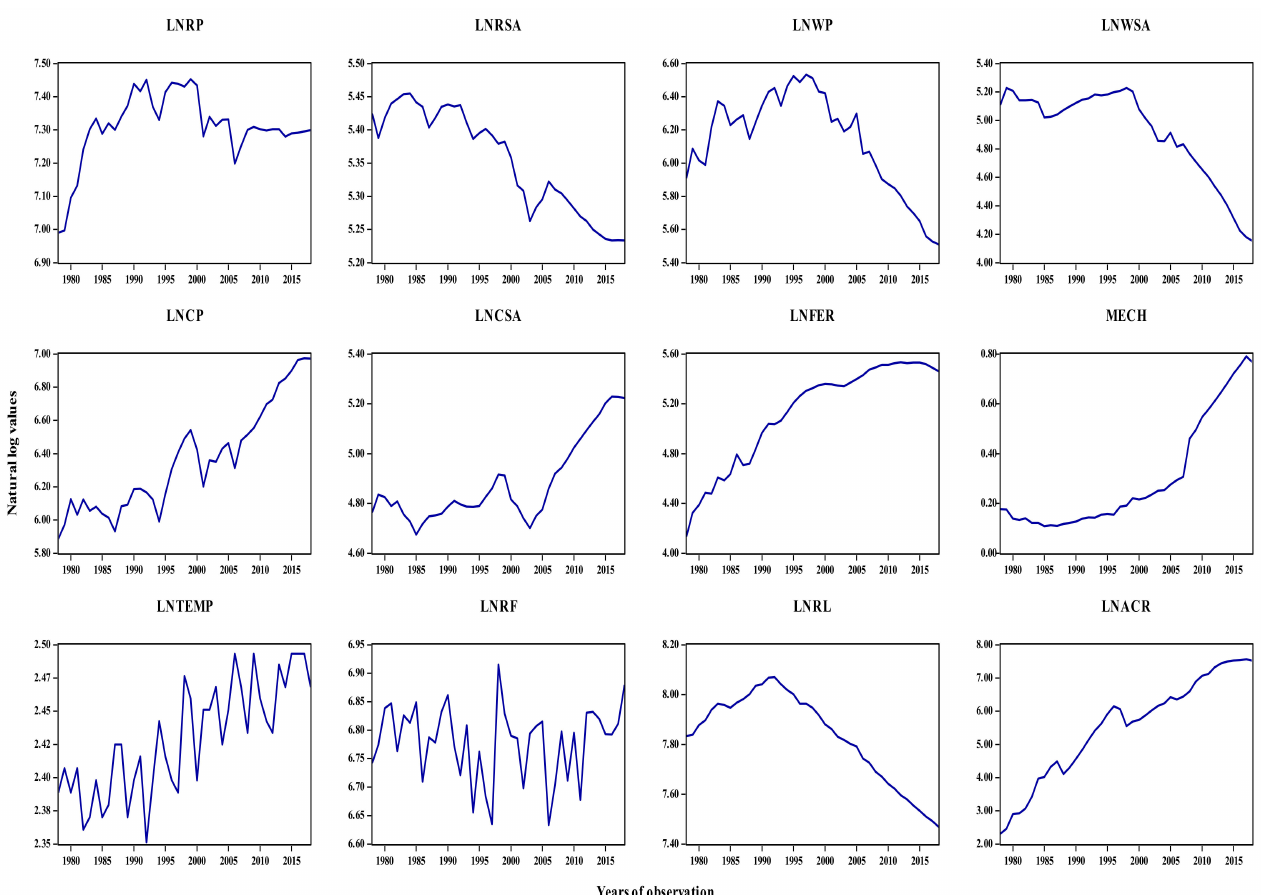
Figure 4. LNRP, LNRSA, LNWP, LNWSA, LNMP, LNMSA, LNFER, LNTEMP, LNRF, LNACR, and LNRL denote the natural log of rice production, rice sown area, wheat production, wheat sown area, maize production, maize sown area, fertilizers used, temperature, rainfall, agricultural credit, and rural labor, while MECH shows mechanical farming